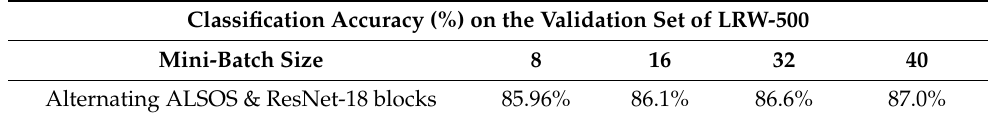
Table 3. Classification accuracy (%) on the validation set of LRW-500 dataset when various mini-batch sizes are utilized in the training of the LR